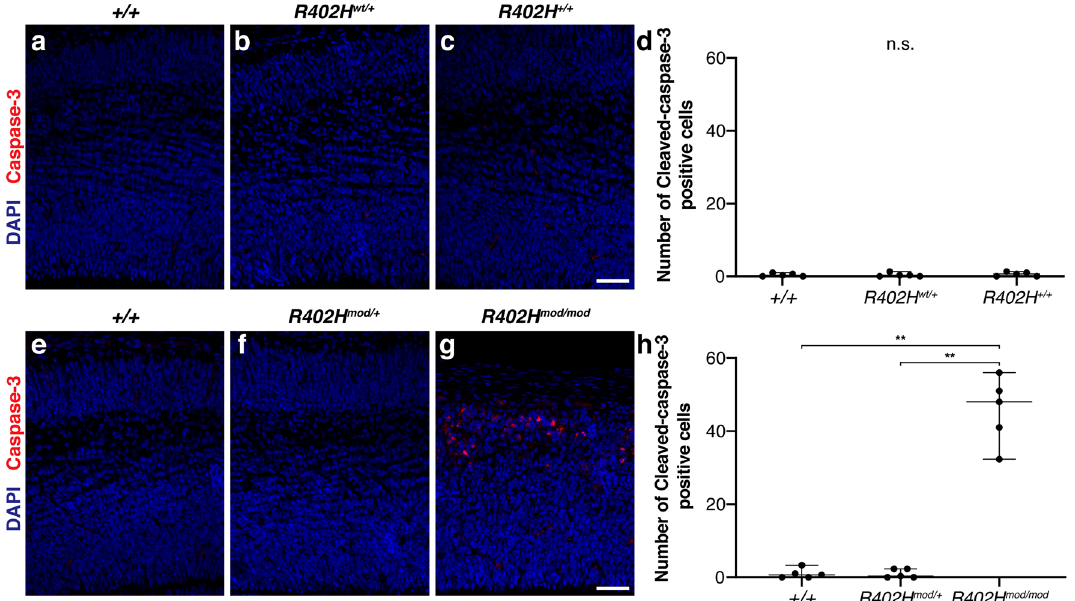
Figure 4. R402H mod /R402H mod embryos have an increase in the number of apoptotic cells. ( a–c ) Representative coronal sections from E16.5 embryos stained for the apoptotic cell marker cleaved-caspase 3. ( a ) Wild-type (+/+); ( b ) heterozygous ( R402H wt / +), and ( c ) homozygous ( R402H wt /R402H wt ) animals contain very few caspase-3-positive cells. ( d ) Quantification of caspase-3-positive cells shows no significant different between homozygous animals and control littermates. ( e–g ) Coronal sections from Tuba1a modified embryos stained for Caspase-3. ( e ) wild-type (+/+); ( f ) heterozygous ( R402H mod / +) and ( g ) homozygous ( R402H mod /R402H mod ) animals. ( h ) Quantification shows that homozygous R402H mod /R402H mod have a significant increase in the number of caspase-3-positive cells compared to wildtype and heterozygous R402H mod /R402H + littermates. P < 0.01**. Error bars show Mean ± SEM. Scale bars indicate 50